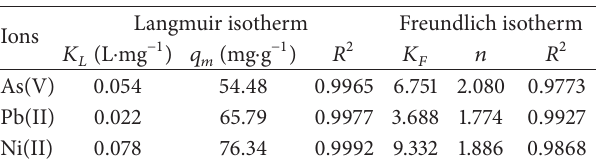
Table 4: Adsorption isotherm parameters for metal adsorption on Fe 3 O 4 /rGO